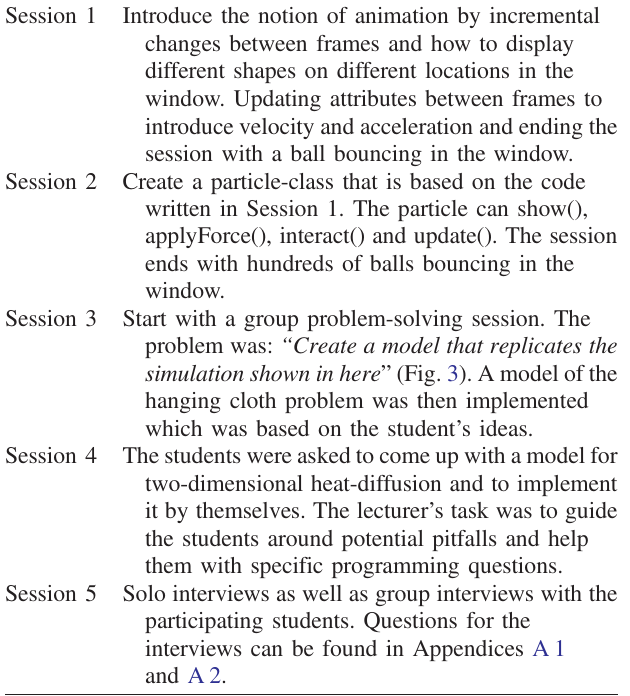
TABLE I. A list of the five different sessions of the workshop with the content of each session. During each session a different aspect is investigated or explored with the students. Each session builds on what was learned in the previous session.